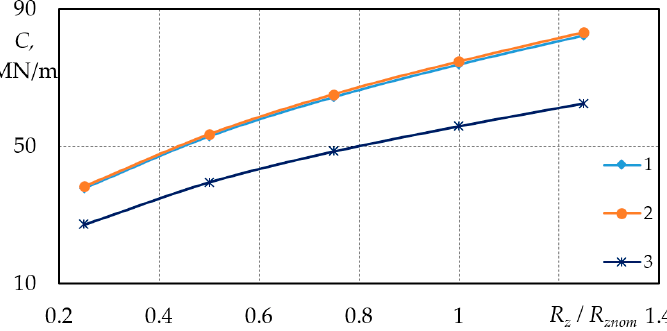
Figure 18. Dependence of the stiffness of the patterned part of tire 175/70R13 on the relative radial load using different models: 1—porous composite model, 2—compressible prism model, and 3— road-tire contact model.